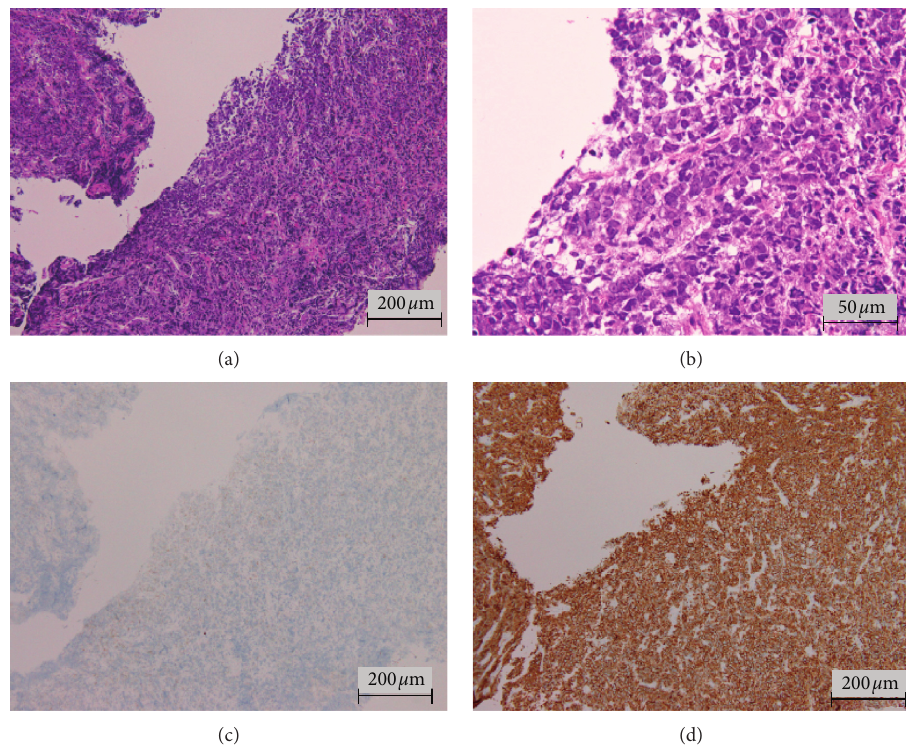
Figure 2: H&E-stained section of bladder tumor (a, b). Immunohistochemical staining of CD20 (c) and CD138 (d). H&E staining showed the proliferation of atypical lymphoid cells with abundant basophilic cytoplasm and pleomorphic nucleoli (a, b). Immunohistochemical staining revealed that these atypical cells were negative for CD20 (c) and positive for CD138 (d).